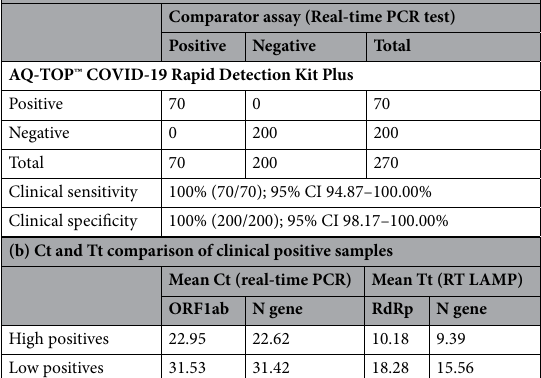
RNA concentration